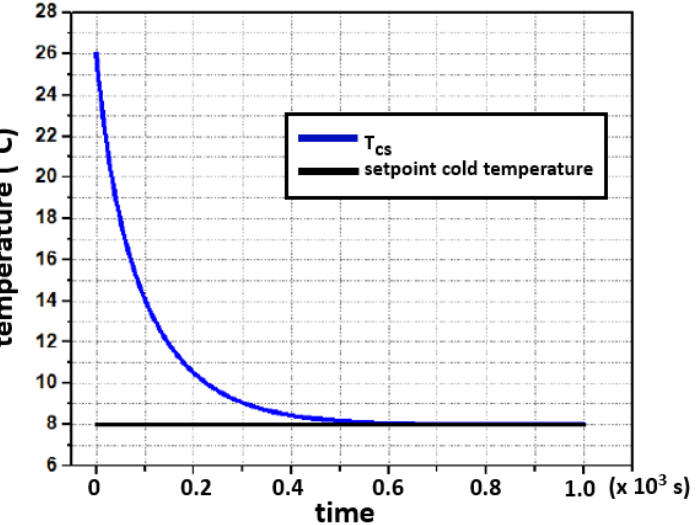
Figure 11. Simulated closed-loop response for a setpoint of 8 ◦ C at the hot side with a starting temperature of 26 ◦